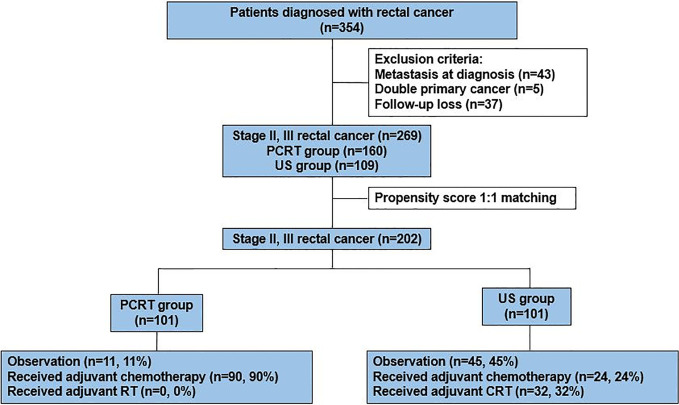
Study scheme. PCRT, Preoperative chemoradiotherapy; US, Upfront surgery.